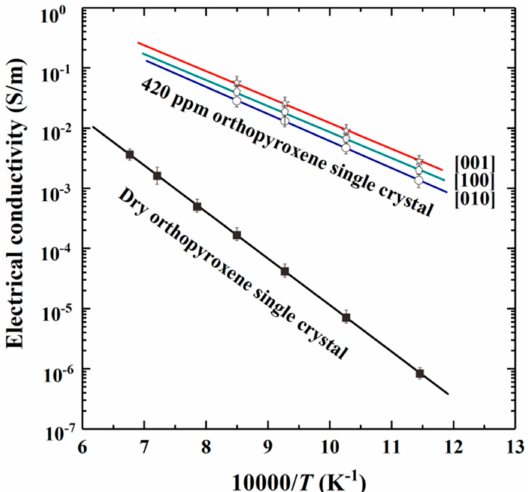
Figure 8. The electrical conductivity of hydrous orthopyroxene single crystals along [100], [010] and [001] crystallographic directions at conditions of 873–1273 K and 8 GPa. The EC of anhydrous sample is also included (modified from Dai and Karato